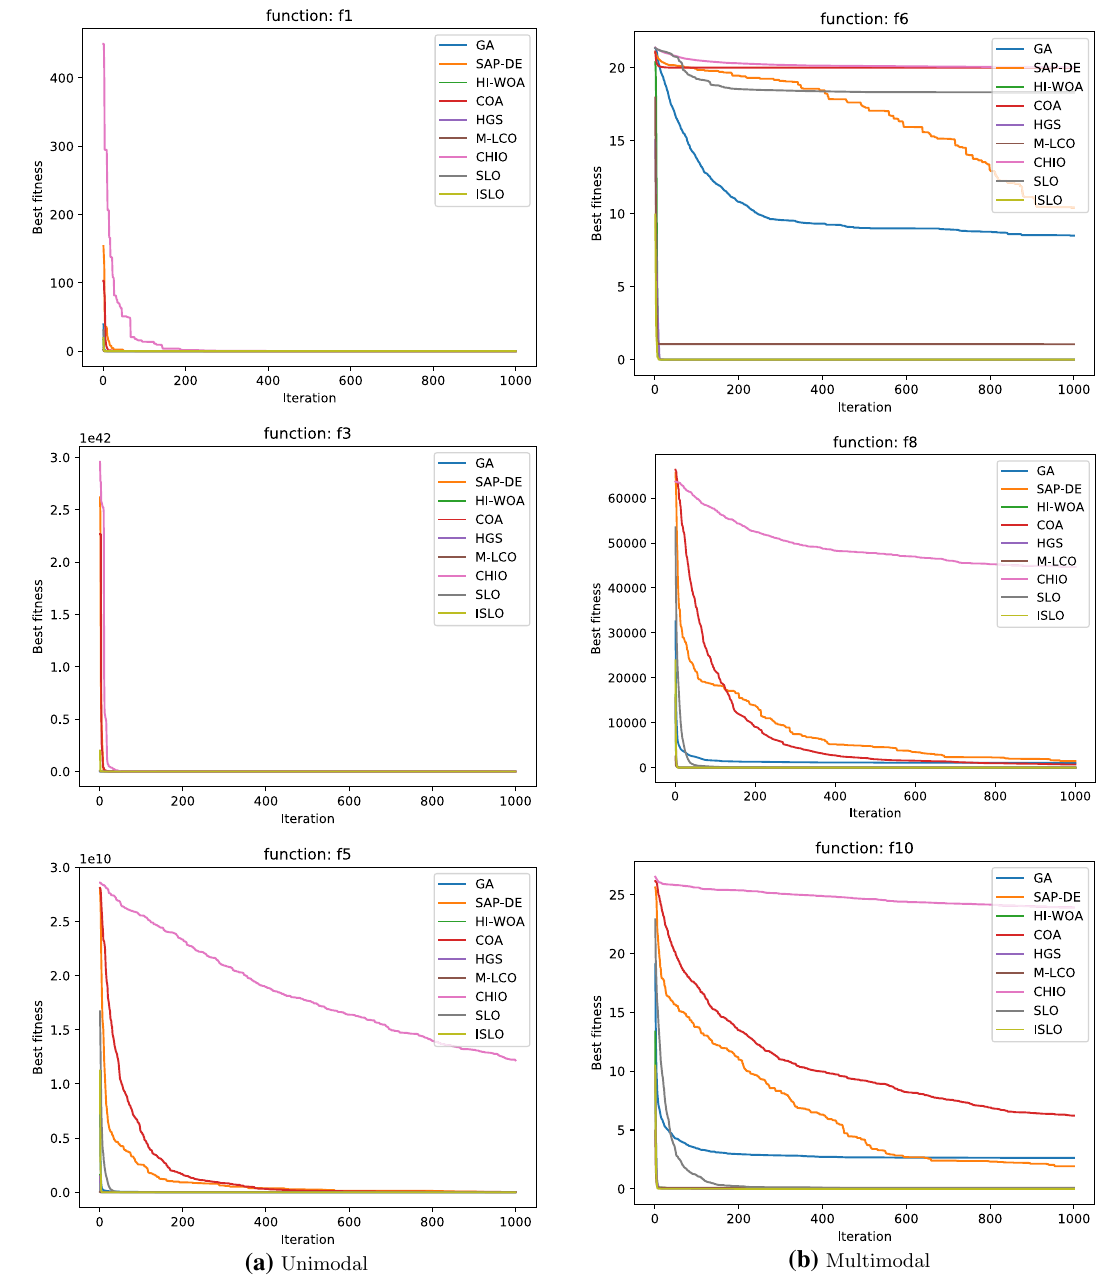
Fig. 5 Convergence speed of each algorithm on unimodal ( a -left side) and multimodal ( b -right side)